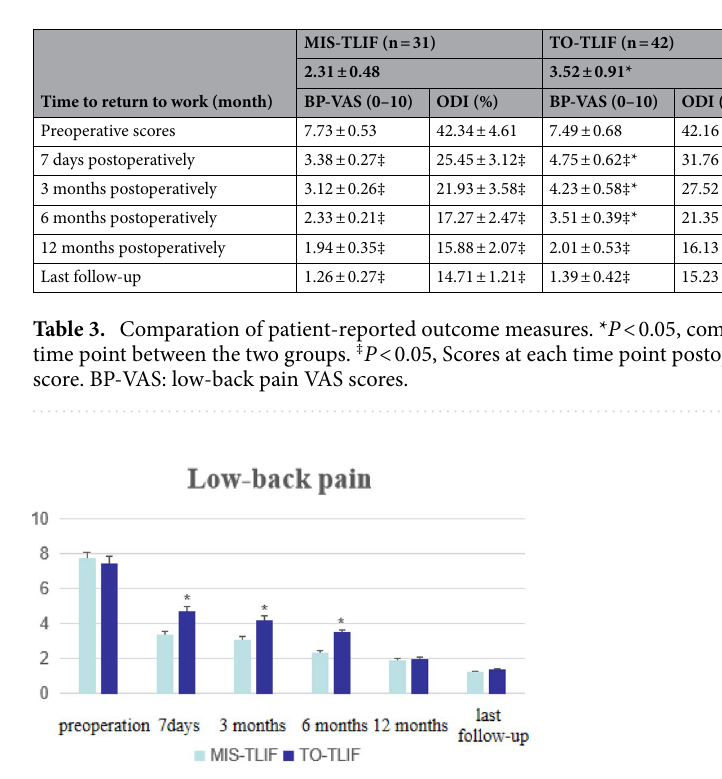
Figure 3. Histograms for low-back pain VAS scores (* P < 0.05, comparation between the two groups).